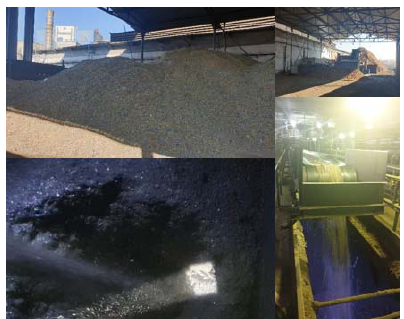
Figure 3. Dosing of solid recovered fuel into tank from landfill of Vojany black coal power plant. Source: Own processing by Vojany black coal power plant (2020).